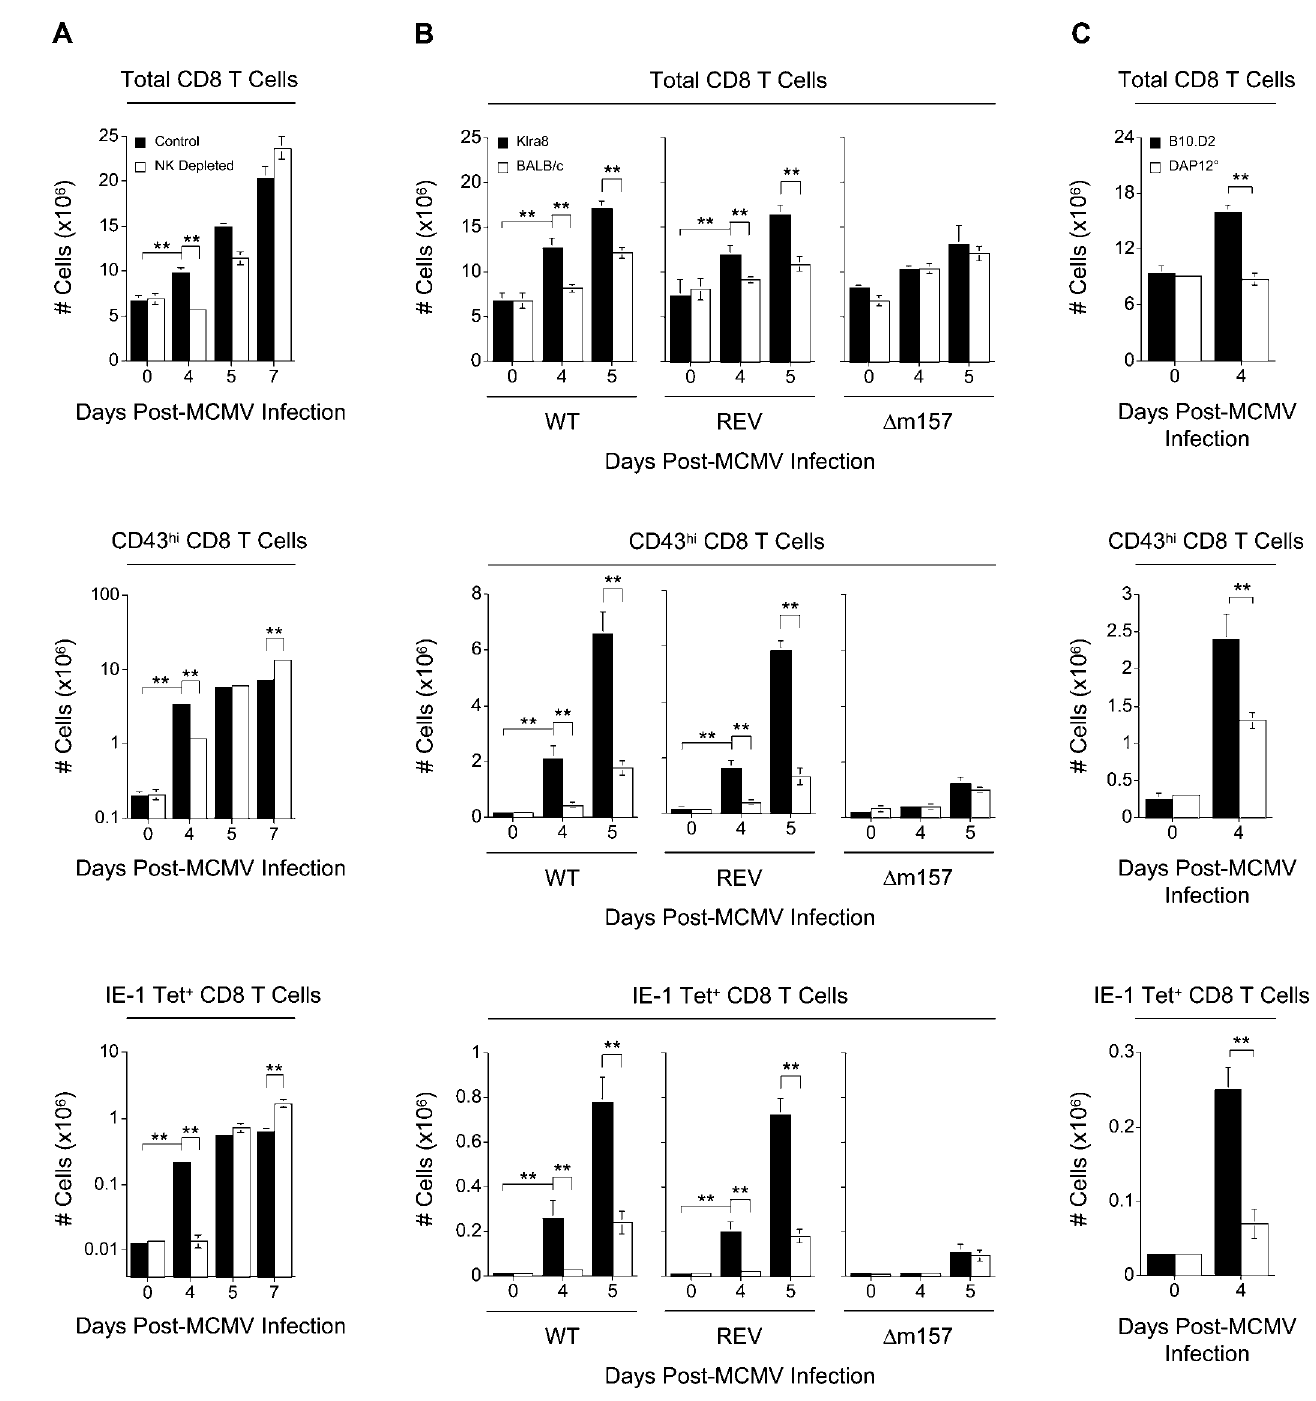
Figure 5. Kinetics of Antigen-Specific CD8 T Cell Expansion in Response to MCMV Infection in Mice Lacking NK Cells or Ly49H-Mediated NK Cell Activation Splenic leukocytes were isolated at the time points indicated from (A) Klra8 mice and Klra8 mice depleted of NK cells infected with MCMV, (B) Klra8 and BALB/c mice infected with in vitro–generated BAC-derived wild-type (WT), revertant (REV), or D m157 viruses, and (C) B10.D2 and B10.D2-DAP12 8 mice infected with MCMV. Total CD8 T cell numbers, CD43 expression on CD8 T cells, and IE-1-loaded MHC class I tetramer binding to CD8 T cells were analyzed for (A–C). Graphs represent total numbers (in millions) of cells for each parameter as indicated. Results are expressed as mean 6 SD of two (A) or three (B, C) mice per group. One experiment representative of two for (A–C) is shown. ** p (cid:3) 0.01.